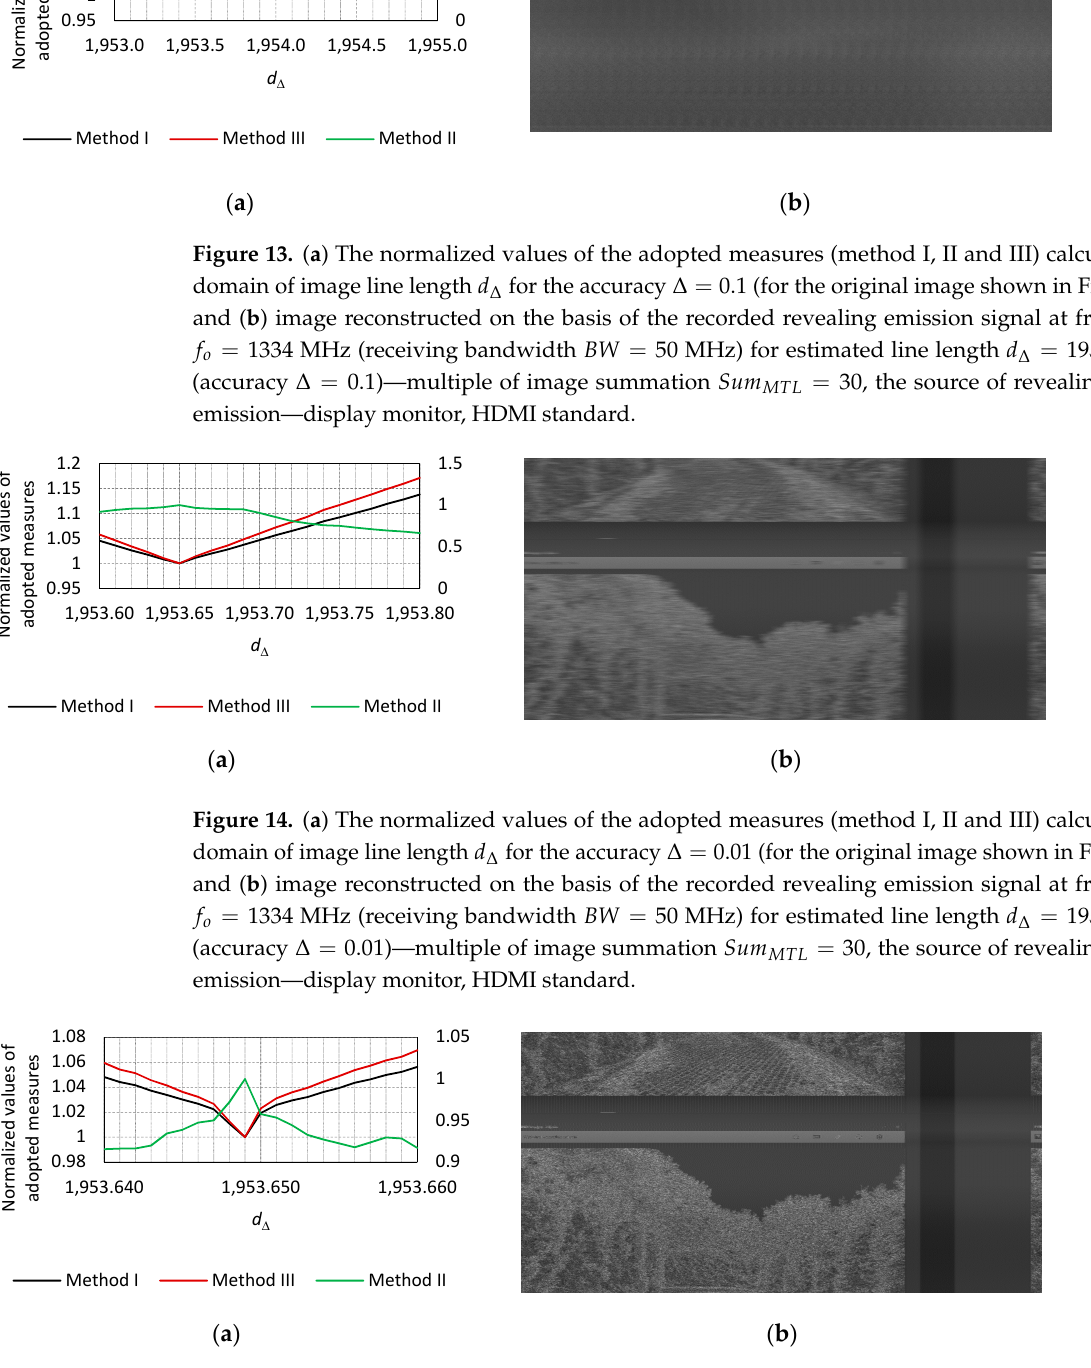
Figure 15. ( a ) The normalized values of the adopted measures (method I, II and III) calculated in domain of image line length 𝑑 ∆ for the accuracy ∆= 0.001 (for the original image shown in Figure 7a) and ( b ) image reconstructed on the basis of the recorded revealing emission signal at frequency 𝑓 (cid:3042) = 1334 𝑀𝐻𝑧 (receiving bandwidth 𝐵𝑊 = 50 𝑀𝐻𝑧 ) for estimated line length 𝑑 ∆ = 1953.64900 (accuracy ∆= 0.001 )—multiple of image summation 𝑆𝑢𝑚 (cid:3014)(cid:3021)(cid:3013) = 30 , the source of revealing signal emission—display monitor, HDMI standard.